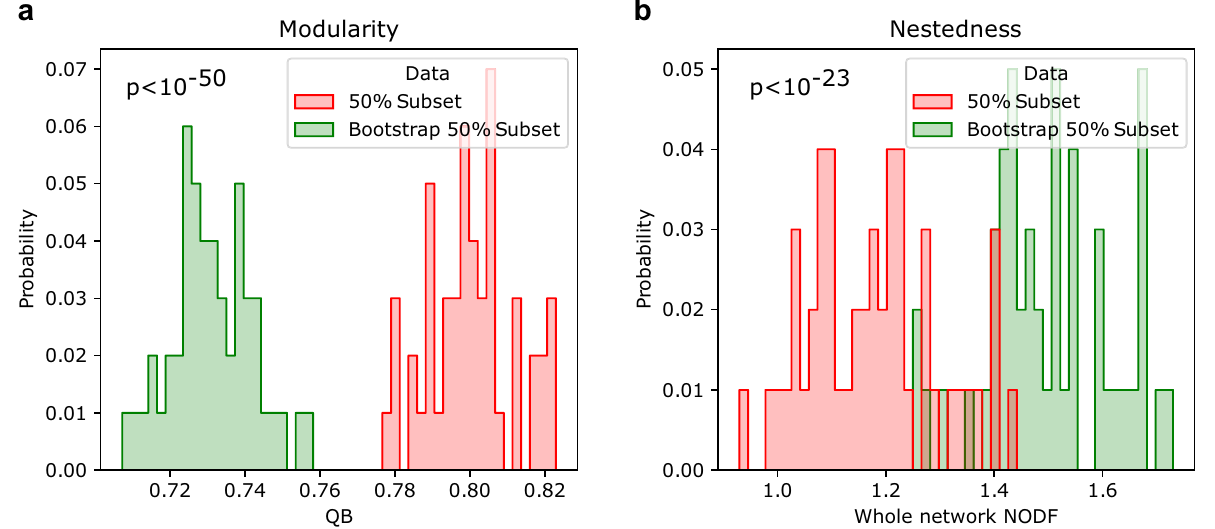
Figure 4. Validation of patterns in subsampled networks. Modularity ( a ) and Nestedness ( b ) patterns for subsampled networks in green (containing randomly half of the reported interactions) as well as their edge randomization counterparts (red). Distributions shown contain 50 independent data points of the subsampling and edge randomization each. The patterns reported for the full network of more modular than expected and less nested than expected are maintained, thus suggesting that these are not caused by sampling